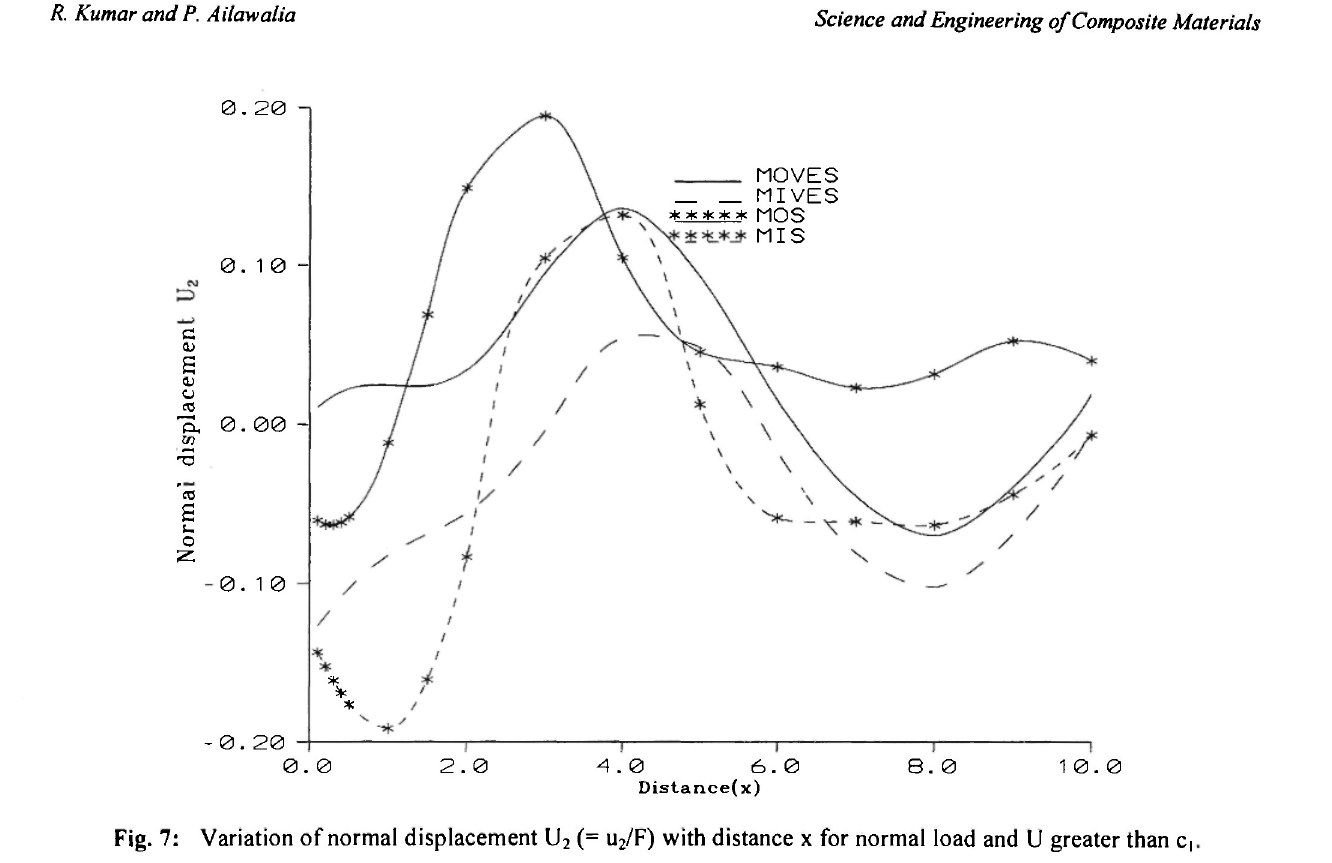
Variation of normal displacement U 2 (= u 2 /F) with distance χ for normal load and U greater than q